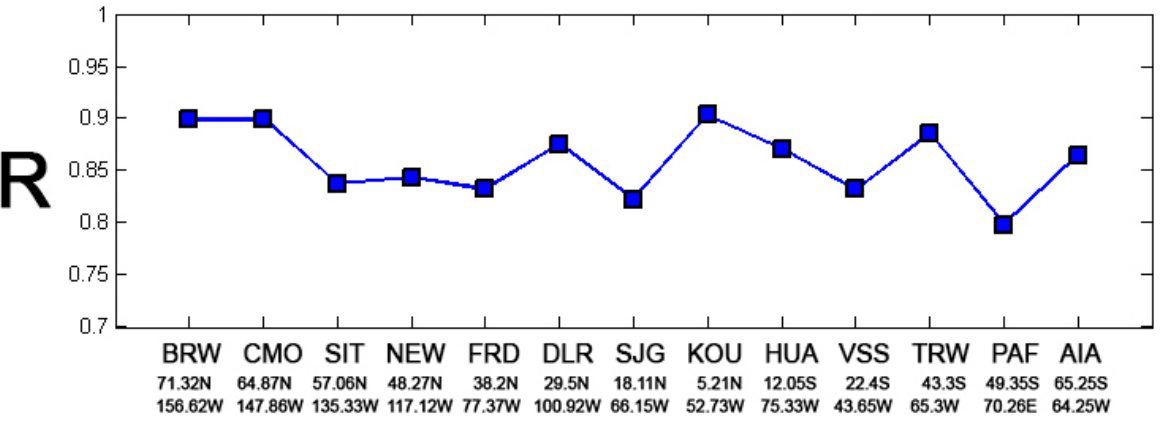
Figure 3. Latitudinal variation of correlation coefficient R between K index and MA for April 2006.